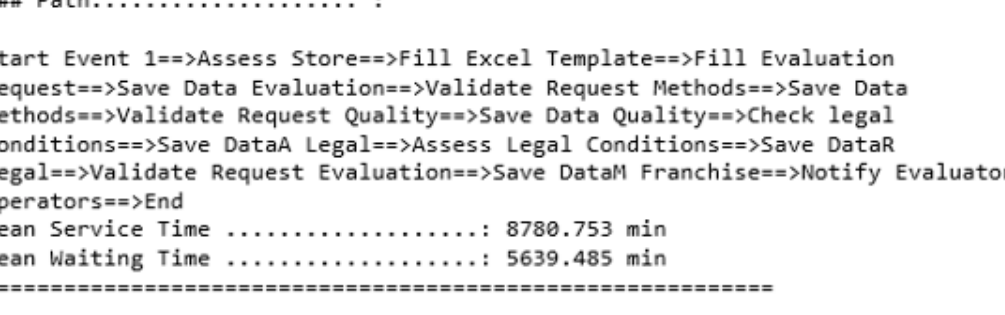
Figure 16. Global results using resource aggregation. Figure 16 Global results using resource aggregation.